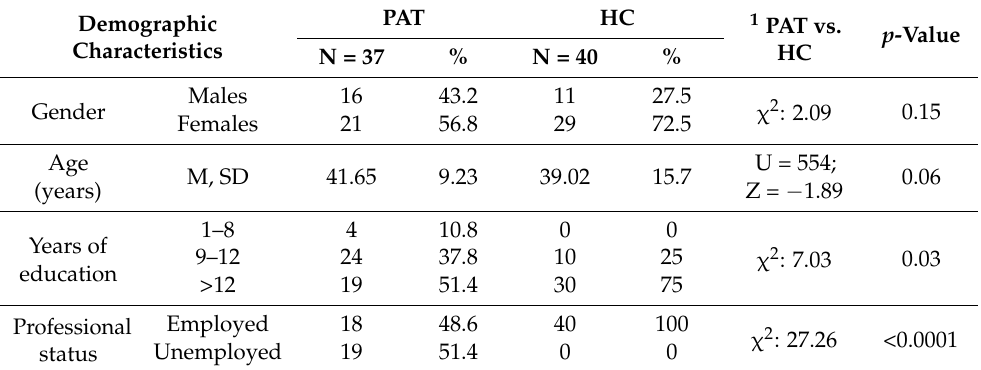
Table 1. Sample demographic characteristics.